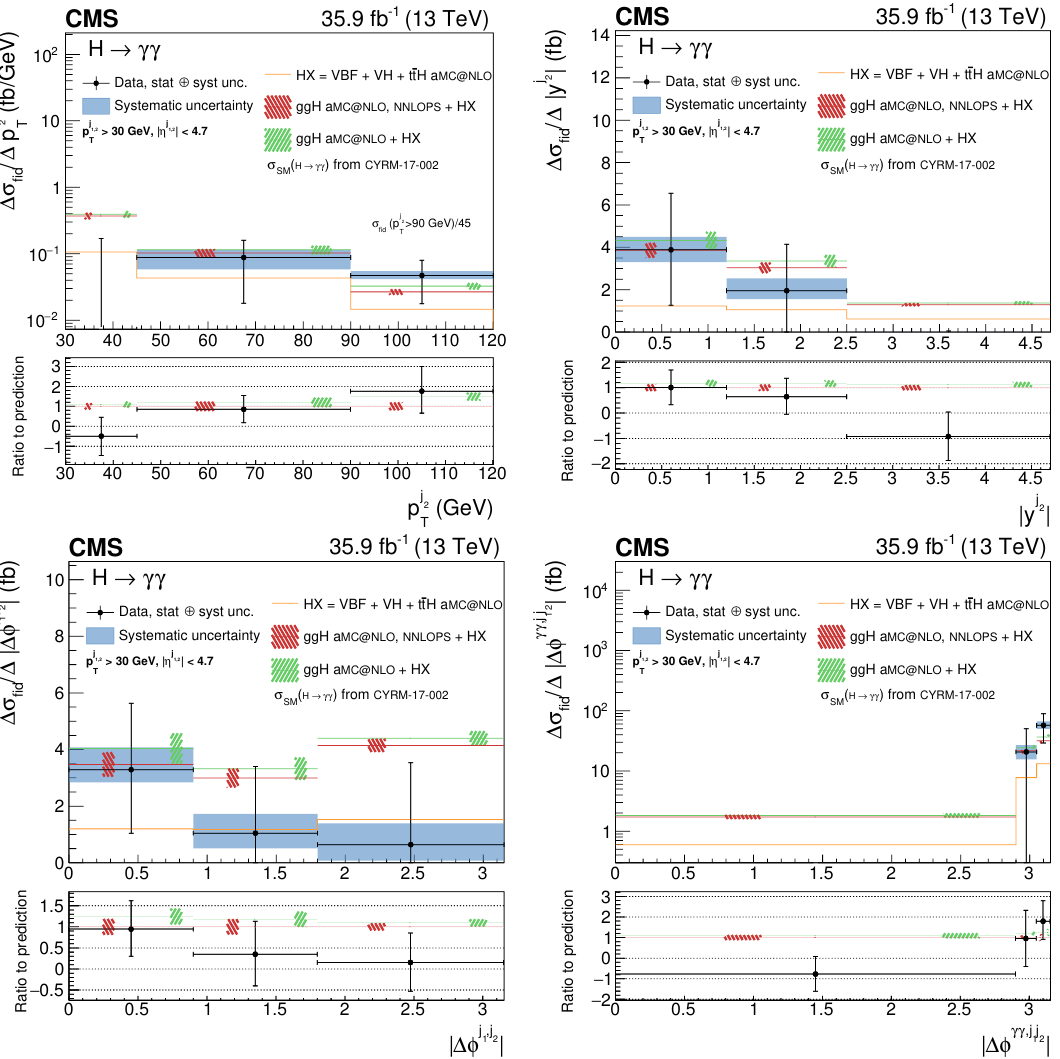
Figure 6 . Measurement of the di(cid:11)erential cross section (black points) as functions of p j 2 j (cid:1) (cid:30) j 1 ;j 2 j , and j (cid:1) (cid:30) (cid:13)(cid:13);j 1 j 2 j . The error bars indicate 1 standard deviation uncertainty. The system- atic component of the uncertainty is shown by the blue band. The measurements are compared to two di(cid:11)erent simulation programs (histograms) with their uncertainties (hatched areas), both normalized to the same theoretical predictions from ref. [13]. When the last bin of the distribution is an over(cid:13)ow bin, the normalization of the cross section in that bin is indicated in the (cid:12)gure.